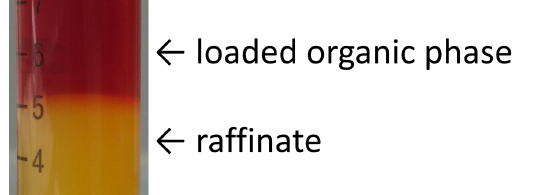
Figure 7. Precipitation of iron oxides/hydroxides from the raffinate at pH eq. = 2.88 (c